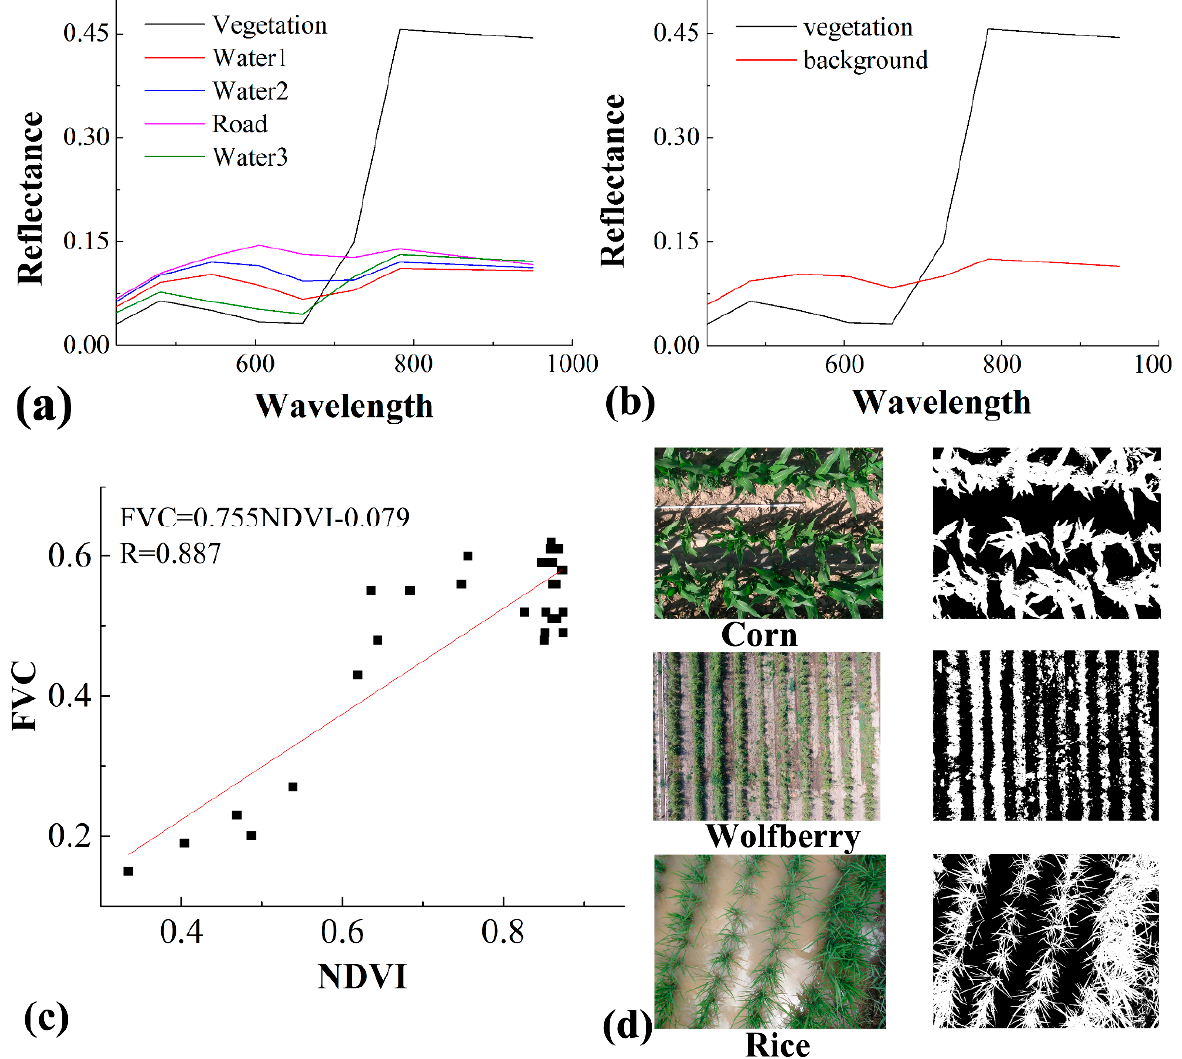
Figure 3. Endmembers, regression relationship, and image involved in digital photography. ( a ) The endmembers involved in U-SMA-2 and C-SMA-2, ( b ) the endmembers involved in U-SMA-5 and C-SMA-5, ( c ) the regression relationship between measured FVC and measured NDVI, and ( d ) the RGM images and binary images involved in digital cover photography.